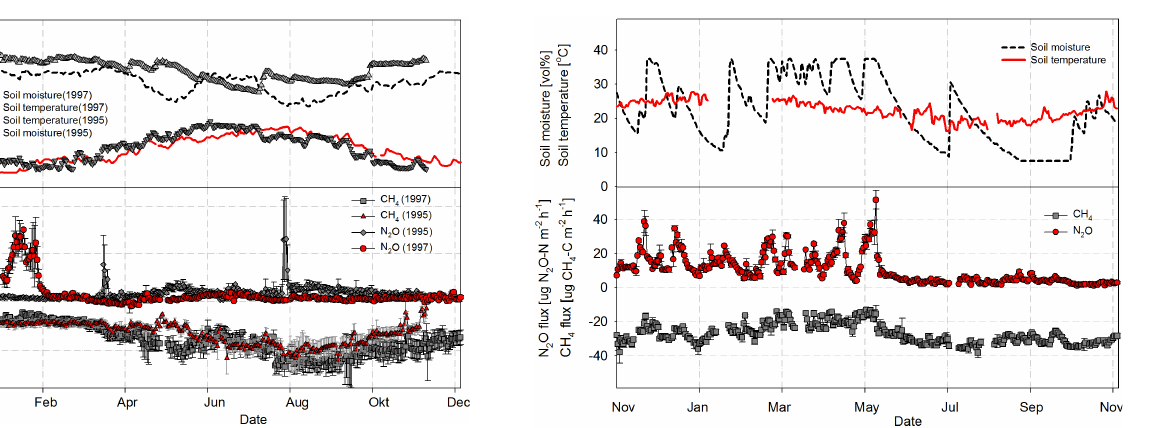
to 50 µg N m − 2 h − 1 ) . However, during the vegetation period, hardly any variability of nitrous oxide fluxes was observed (Figs. 1, 2). In contrast, nitrous oxide fluxes at the tropical forest site were obviously linked to changes in soil moisture (up to 50 µg N m − 2 h − 1 in the wet season) and were between 5 and 10 µ N m − 2 h − 1 during the dry season from May 2002 to November 2002 (Fig.